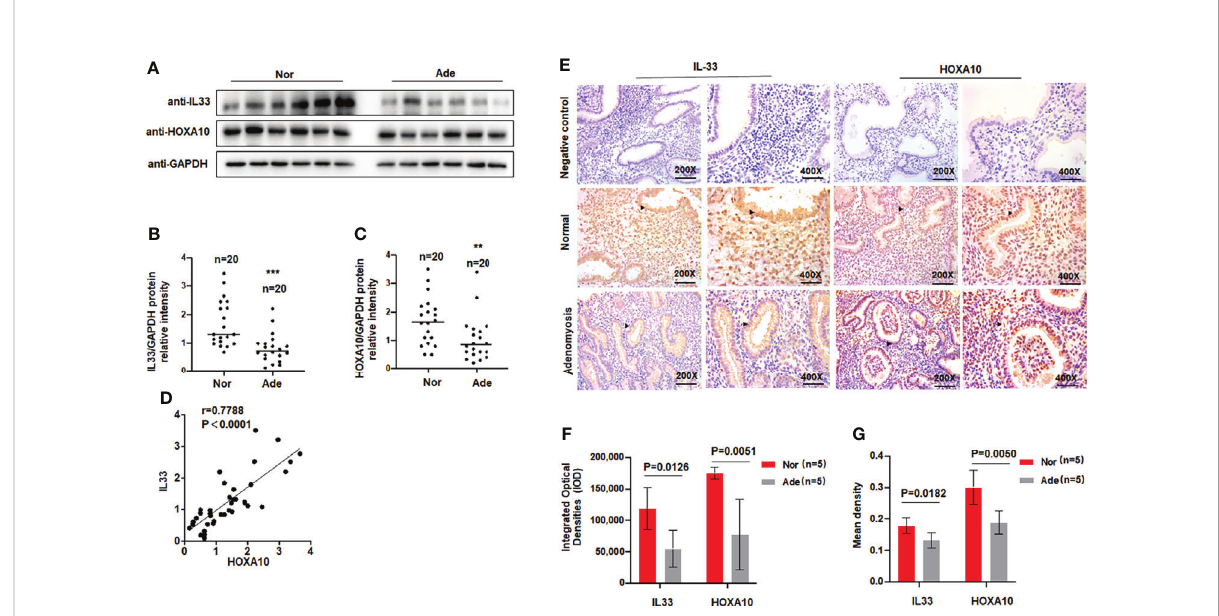
FIGURE 1 IL33 is aberrantly expressed in the endometria of women with adenomyosis. (A) IL33 and HOXA10 protein expression in normal (n = 20) and patients with adenomyosis (n = 20) was analyzed by Western blot. (B) The intensities of IL33 signals were quanti fi ed from the 20 samples and normalized. to GAPDH. ***p < 0.001. (C) The intensities of HOXA10 signals were quanti fi ed from the 20 samples and. normalized to GAPDH. **p < 0.01. (D) Correlation between IL33 and HOXA10 protein expression levels (r = 0.7788, p < 0.0001). (E) Timed mid-secretory endometrial biopsies from healthy control and infertile women with adenomyosis were analyzed using immunohistochemistry (IHC). Rabbit or Goat IgG was used as the negative control. The arrows show the decreased IL33 and HOXA10 conjugates in the endometrial epithelium cell. (F) The integrated optical densities (IOD) of the expression of IL33 and HOXA10 in the endometrium using Image-Pro Plus System 6.0 image analysis software. (G) The mean density of the expression of IL33 and HOXA10 in the endometrium. using Image-Pro Plus System 6.0 image analysis